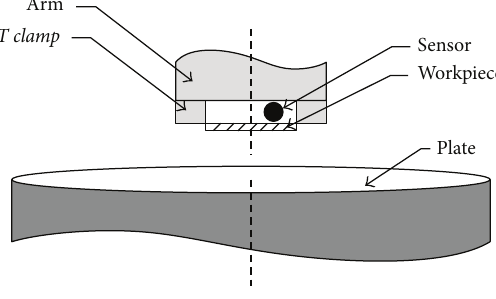
Figure 11: Schematic view of the experiment.